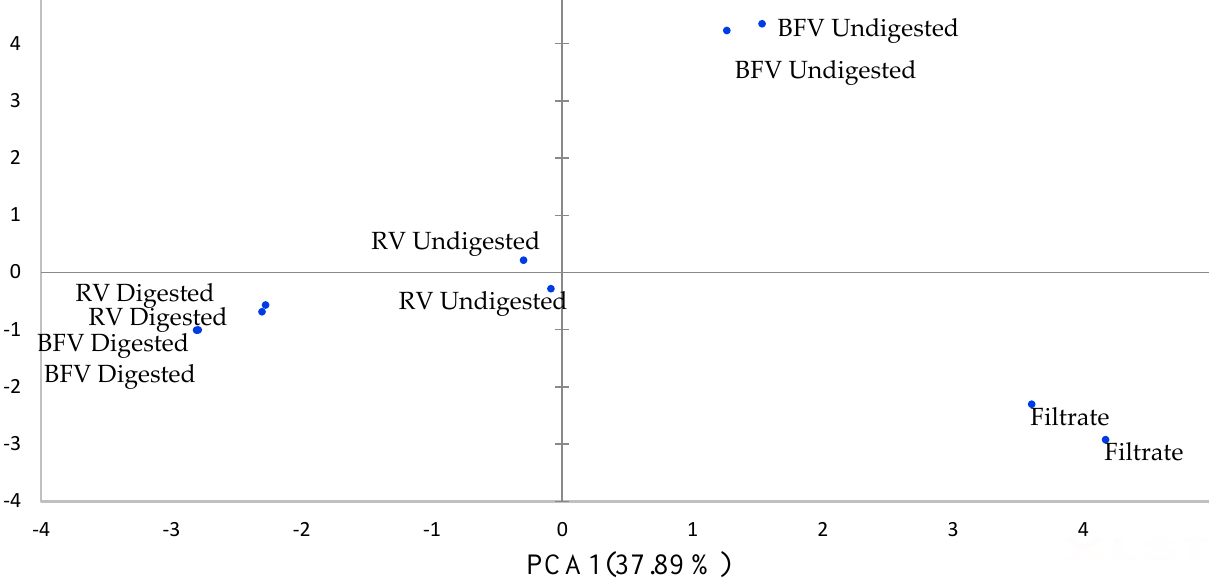
Figure 1. Principal component analysis (PCA) scores of the African pumpkin, RV-Raw Vegetable, BFV-Boiled Filtered Vegetable.